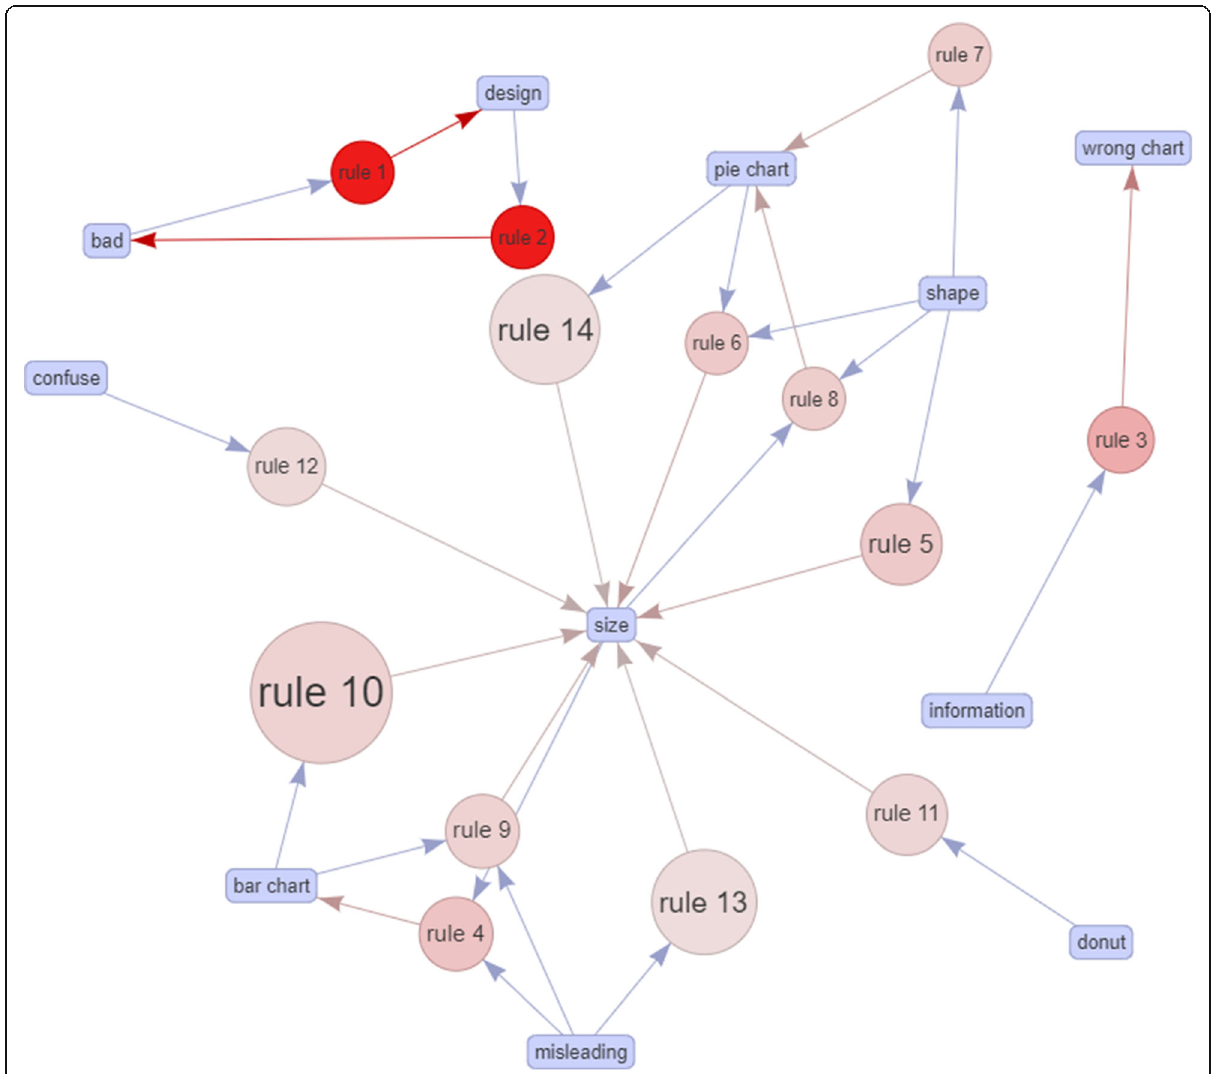
Fig. 5 Graph-based visualization on the relationship between individual items in the